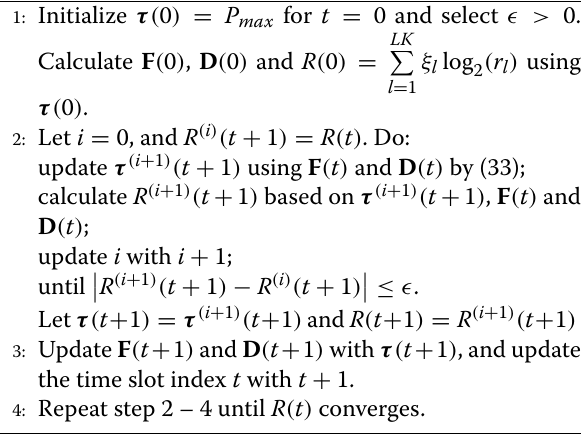
Algorithm 1 : Approximated Sum SE Maximization Power Control Algorithm